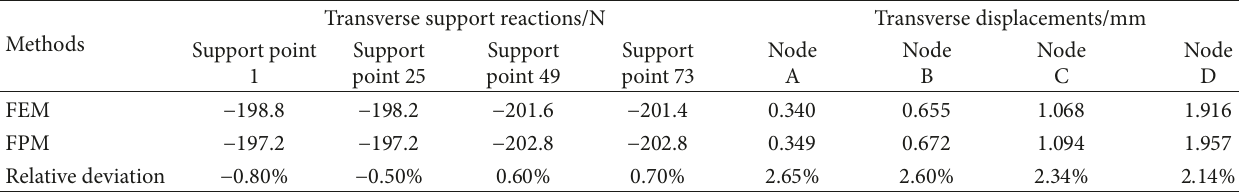
Table 3: Support reactions and horizontal displacements of nodes under horizontal loads.